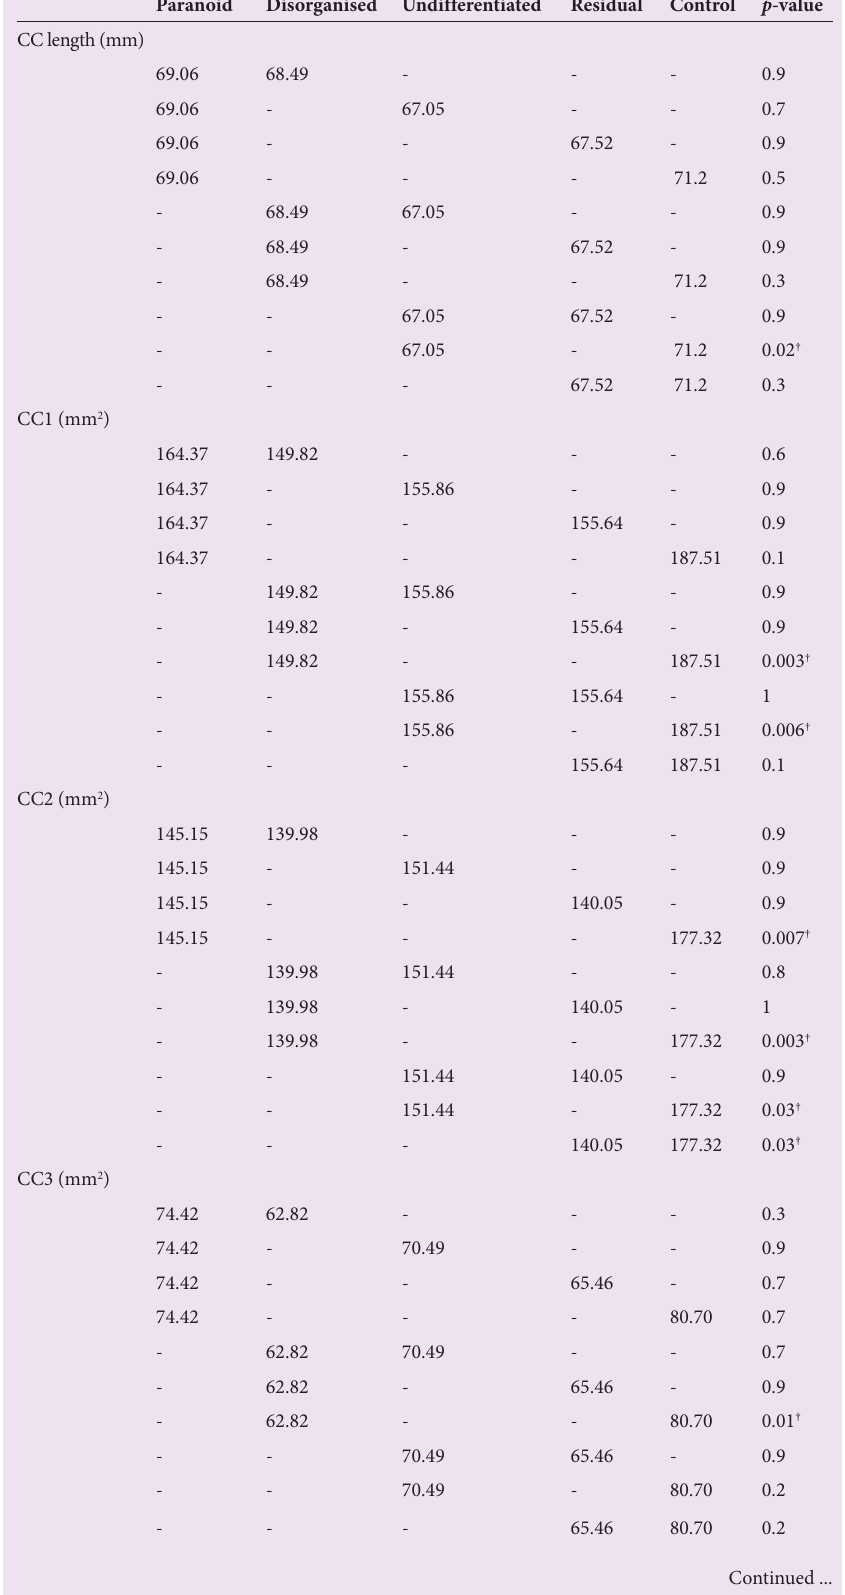
Table 3. Midsagittal CC length and area measurements for each of the five